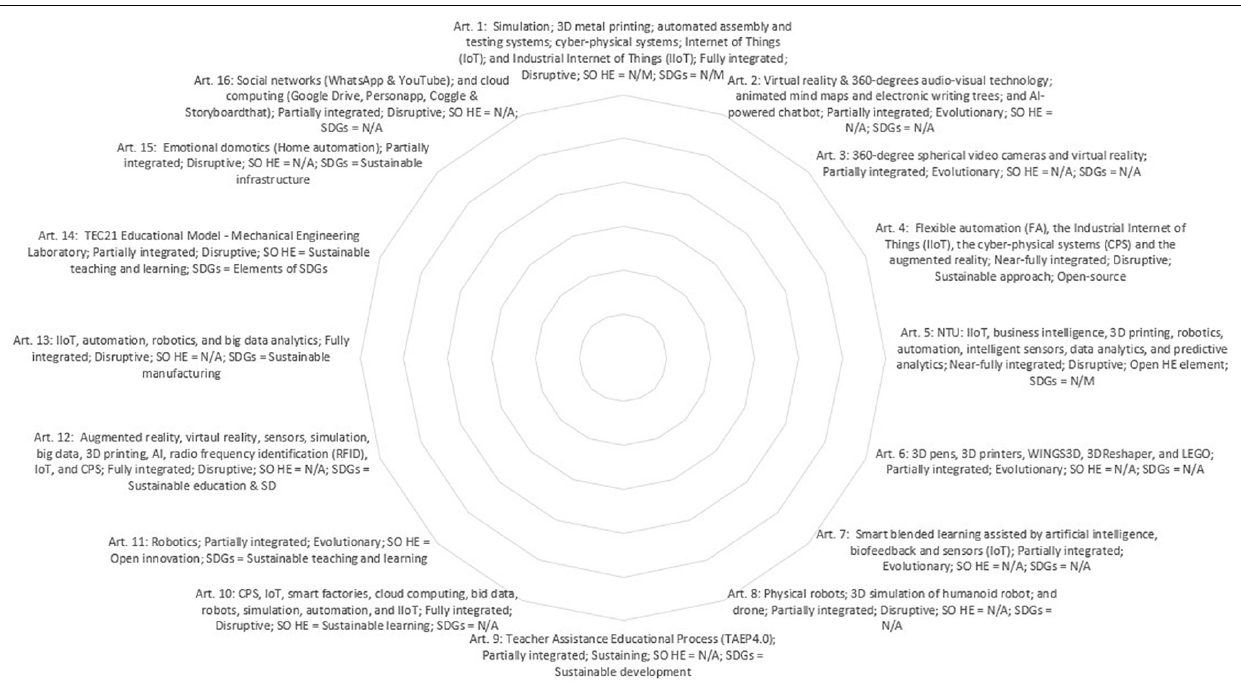
FIGURE 2 | Articles and Education 4.0 technologies used. N/A, not applicable; N/M, not mentioned; SO HE, sustainable open higher education; SDGs, sustainable development